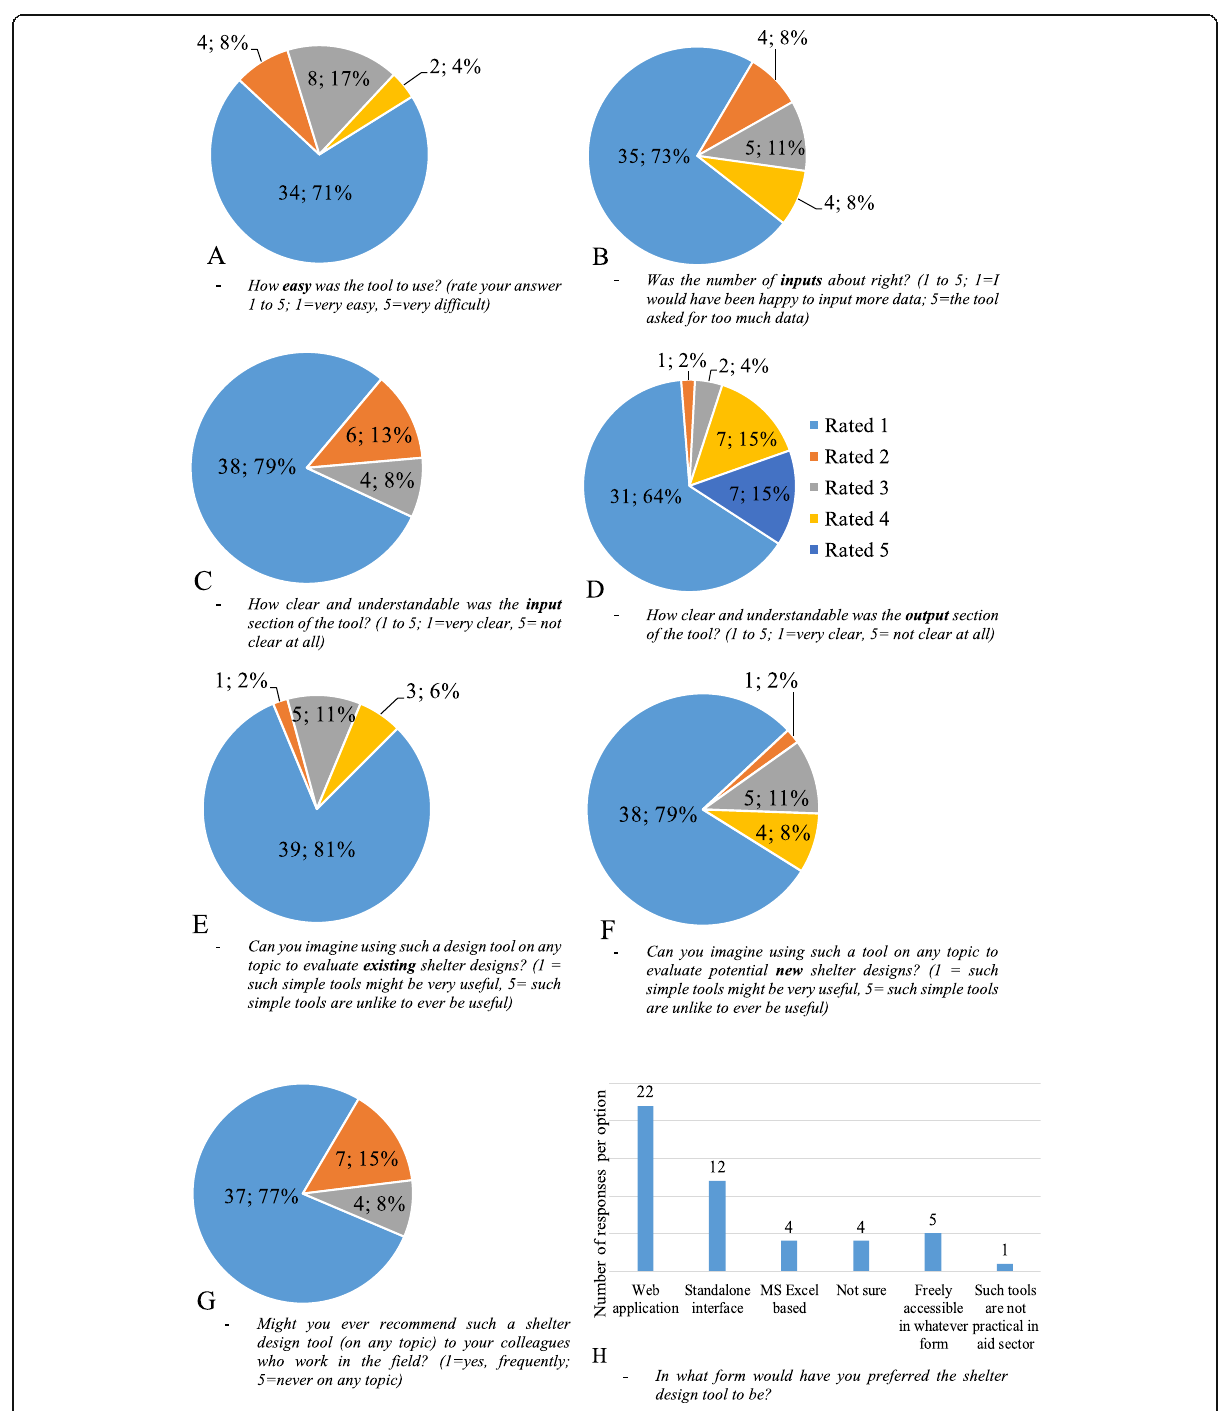
Fig. 12 Post-use evaluation